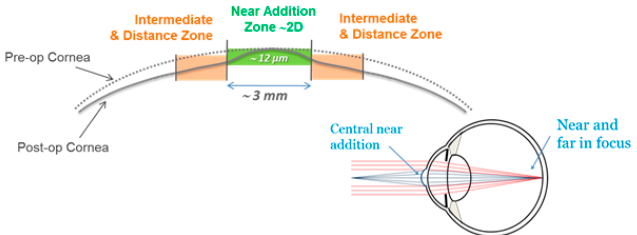
Figure 1. Schematic description of the Supracor treatment. The multifocal ablation pattern combines a regular ablation for the subjects’ ametropic condition (shown in orange) with a 3-mm central zone near the vision add-on (shown in green). The add-on typically adds 2 diopters of refractive power to the central cornea.